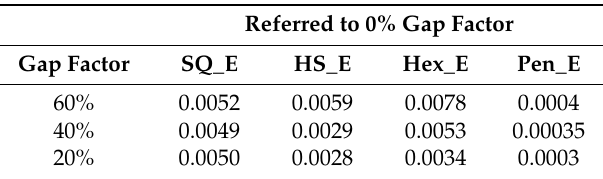
Table 1. The average MSE of orientation of four image types with different configurations of gap factor referred to the 0% gap factor.